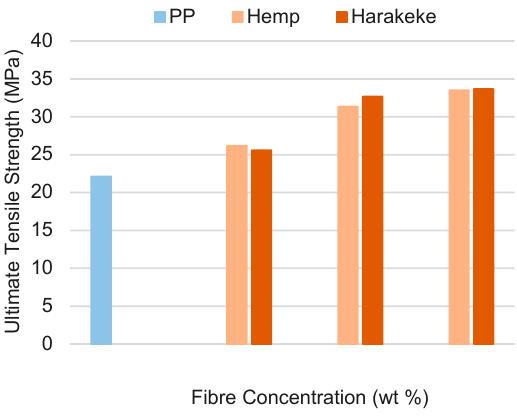
Figure 9. Ultimate tensile strength of fiber reinforced filaments versus fibre content.